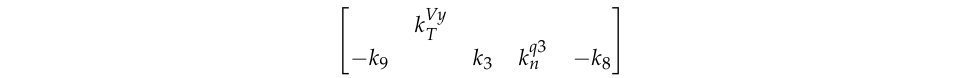
Table 9. The regulator matrix for longitudinal motion in ascending/descending evolution K .